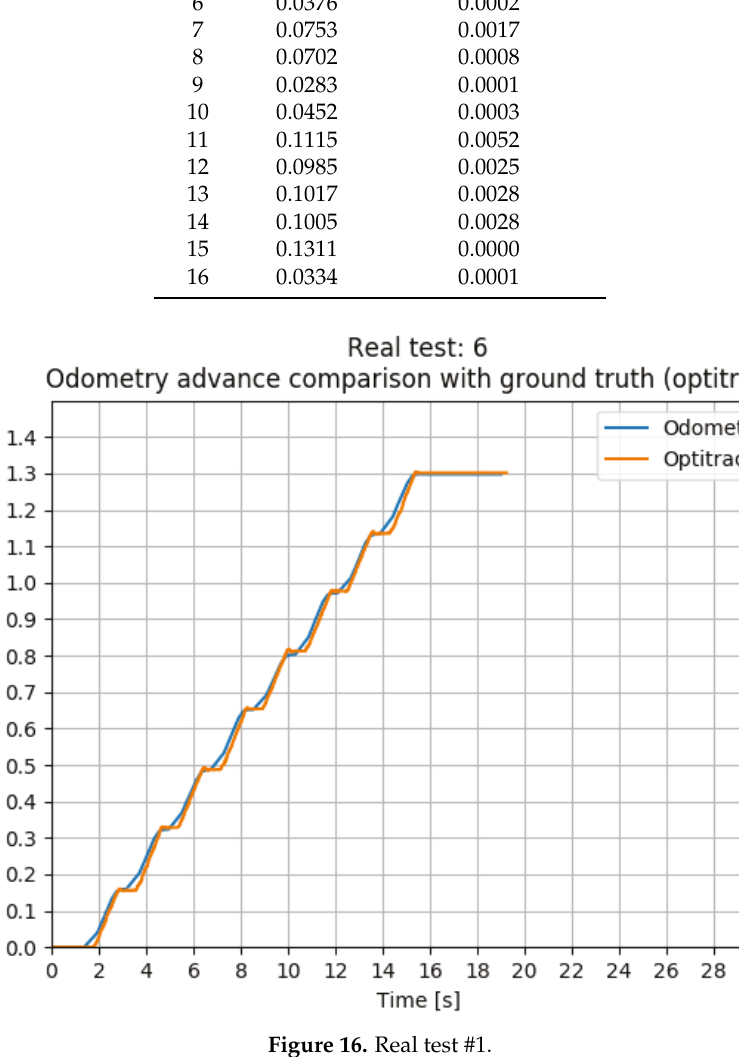
Table 6. Error results for the real forward tests.